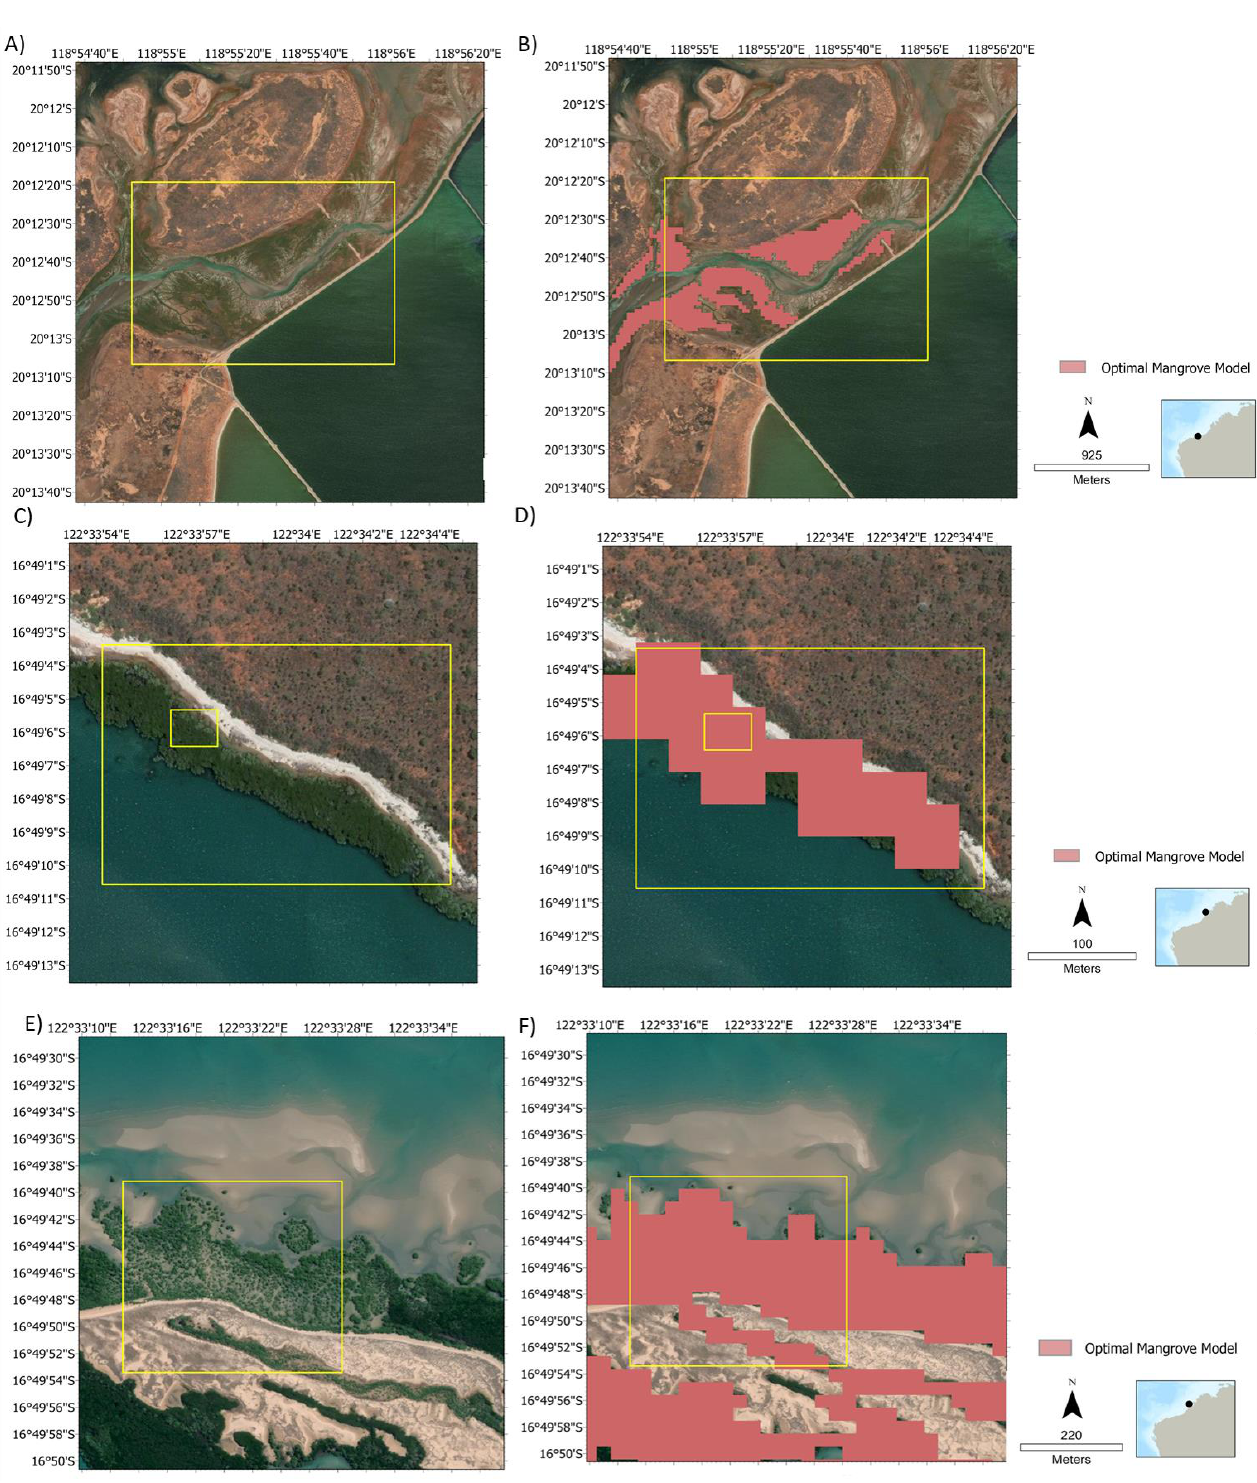
Figure 5. Areas of mangrove that were identified in the optimal WA mangrove model (red). Yellow box refers to areas not previously mapped in [12 – 14] layers. ( A , B ) mangroves adjacent to salt ponds that were detected in the WA optimal WA mangrove model (( B ) — red). ( C , D ) Fringing mangroves with low width detected areal extent in the optimal WA mangrove model (( D ) — red). ( E , F ) Less dense section of fringing mangroves detected ( E ) — yellow box] in the WA optimal WA mangrove model (( F ) — red). See SI for further examples of ( E , F ).